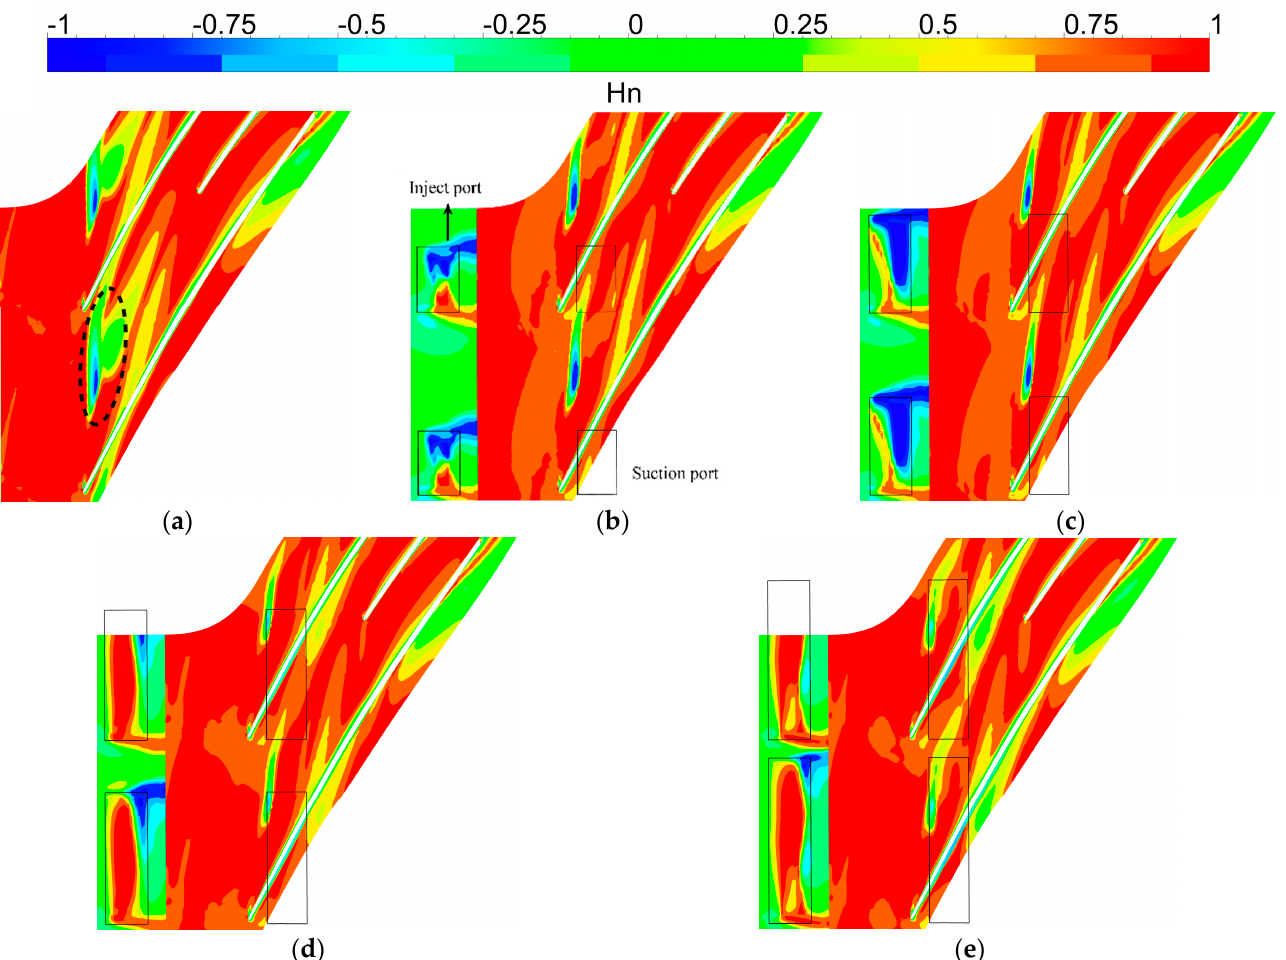
Figure 17. Non-dimensional helicity distribution of different casing structures at 98% blade span.